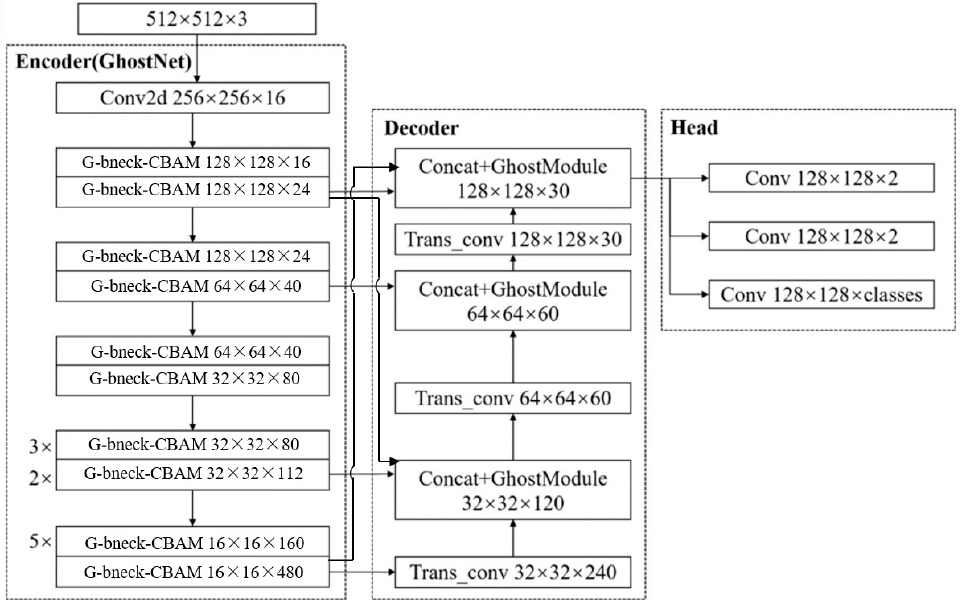
Figure 13. The lightweight multiscale fusion CBAM-Mini network.